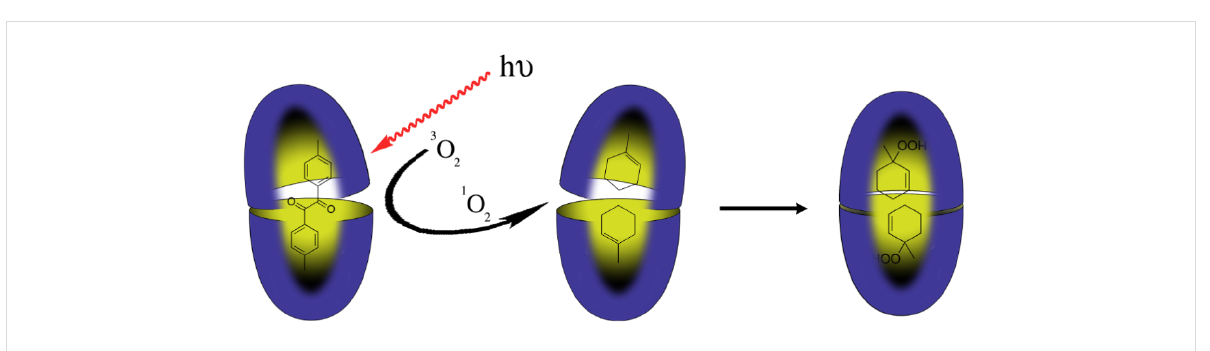
Figure 8: A dendrimer-coated cavitand.